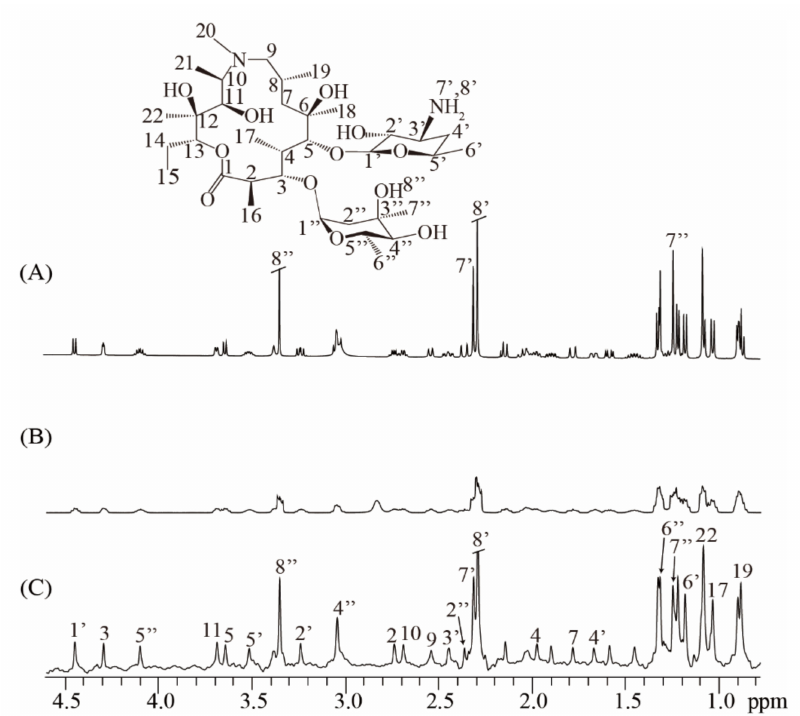
Figure 4. Real-time ZS-IR / CPMG experiments on the practical sample of azithromycin. The molecular structure of azithromycin is at the top. ( A ) Conventional 1D NMR spectrum acquired in homogeneous fields. ( B ) Conventional 1D NMR spectrum directly acquired without the procedure of field shimming and locking, thus su ff ering from inhomogeneous line broadening of 29.3Hz. ( C ) High-resolution 1D pure shift spectrum obtained by the real-time ZS-IR / CPMG under the same non-ideal field condition as ( B ). Table 2. T 2 relaxation values and errors of some typical peaks of azithromycin by Real-time ZS-IR / CPMG under non-ideal field condition and conventional IR / CPMG under a well-shimmed magnetic field. Proton Chemical Shift